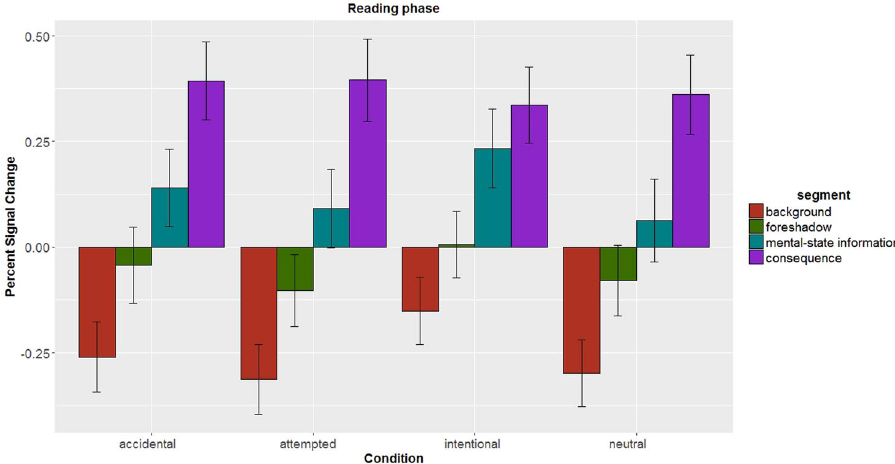
Figure 8. The empathy network encodes harmfulness of outcomes. The estimated PSC across all ROIs of the empathy network during the reading phase text, i.e. when the participants were provided with information about background, foreshadow, beliefs ( mental-state information ), and outcomes ( consequence ). The PSC in the network was significantly greater than the baseline when outcome information was provided, but not when other type of information was provided. Error bars correspond to 95% confidence